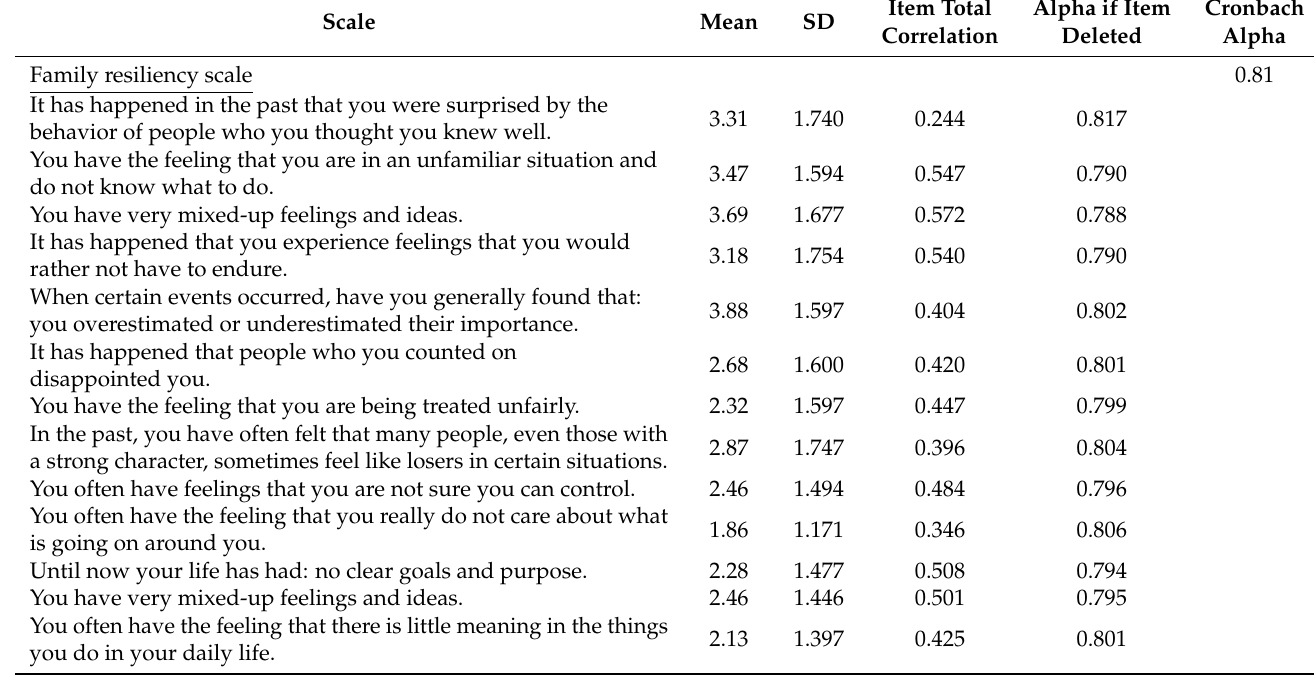
Table 1. Reliability of measures for household resiliency ( n = 570).